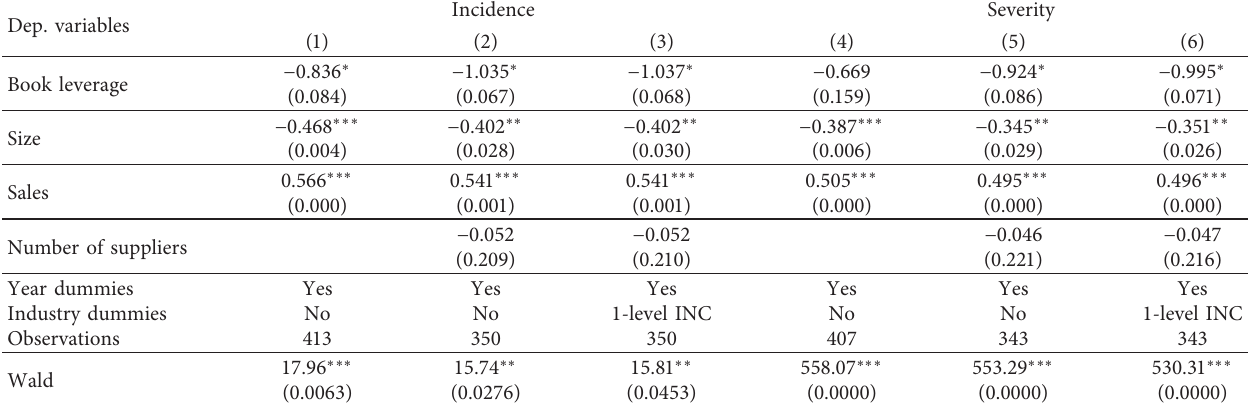
Table 4: The likelihood being affected by incidence/severity of product-harm